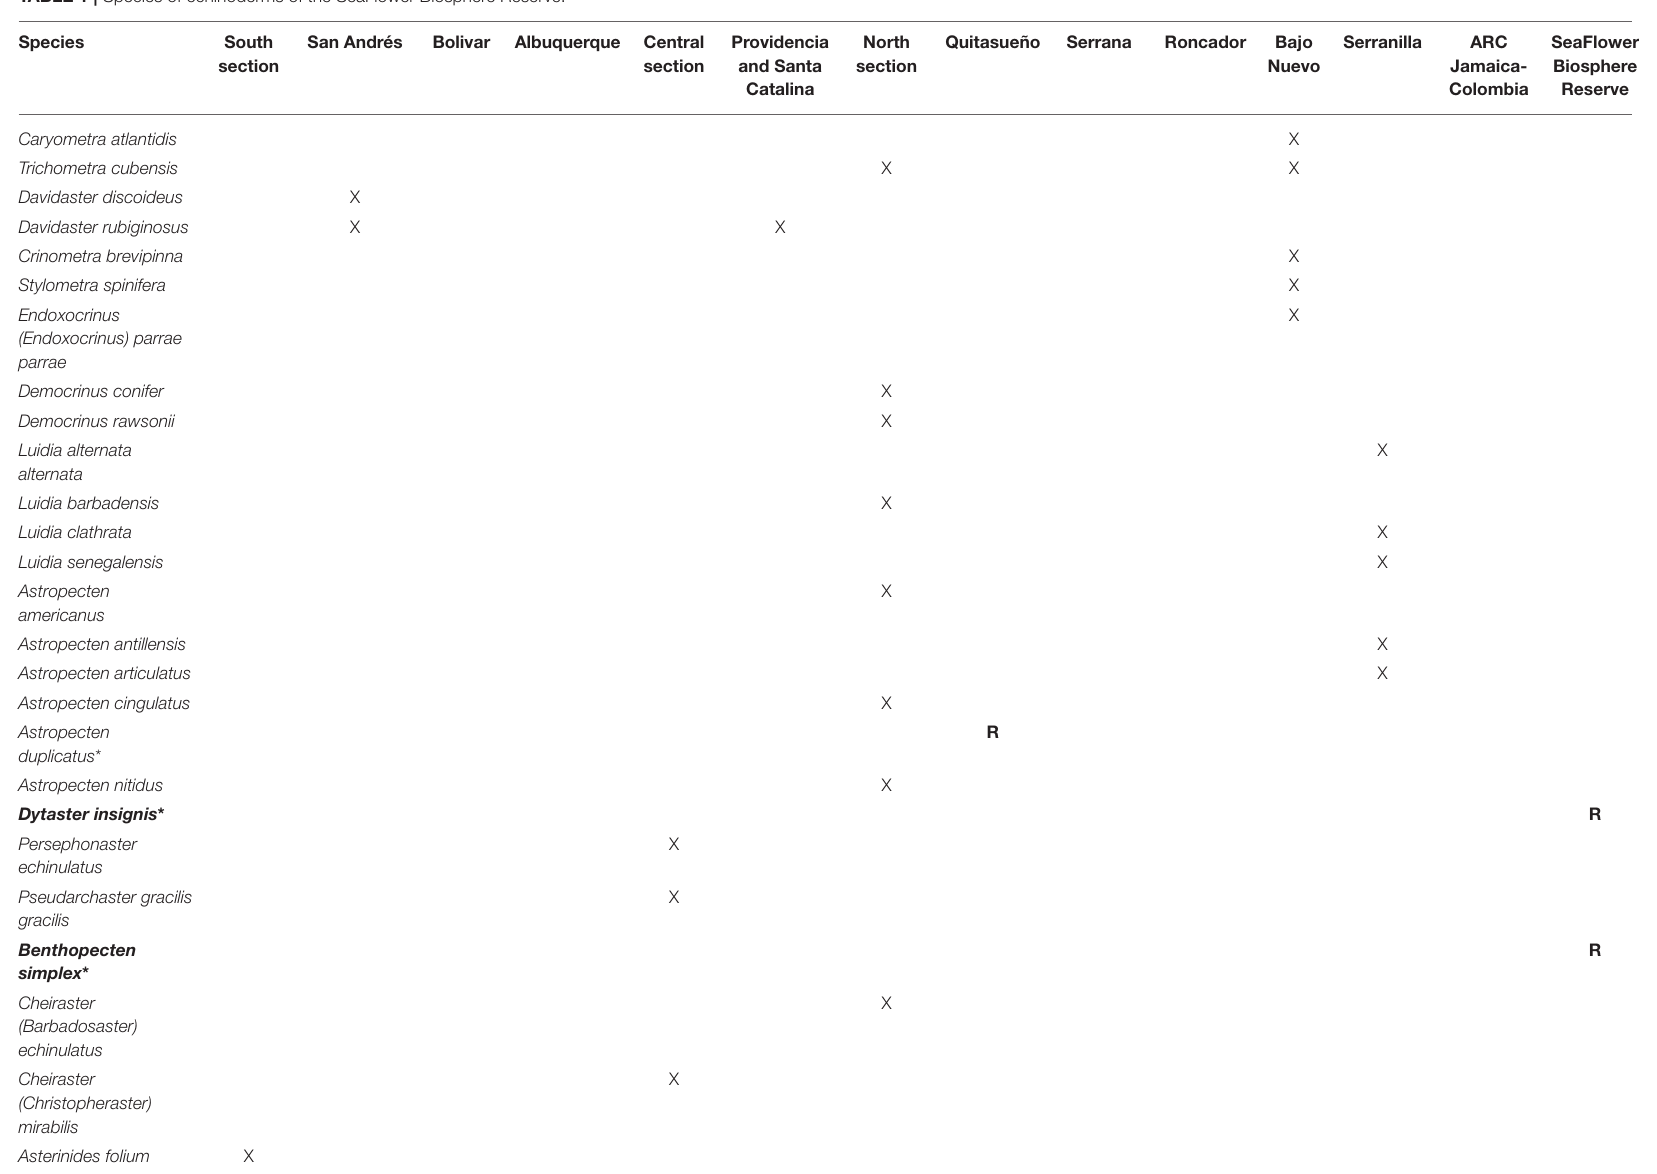
TABLE 1 | Species of echinoderms of the SeaFlower Biosphere Reserve.